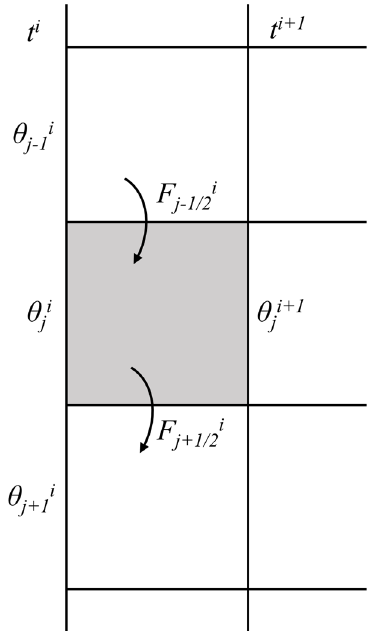
Figure 2. Illustration of the Finite Volume Scheme for updating the cell values by the boundary